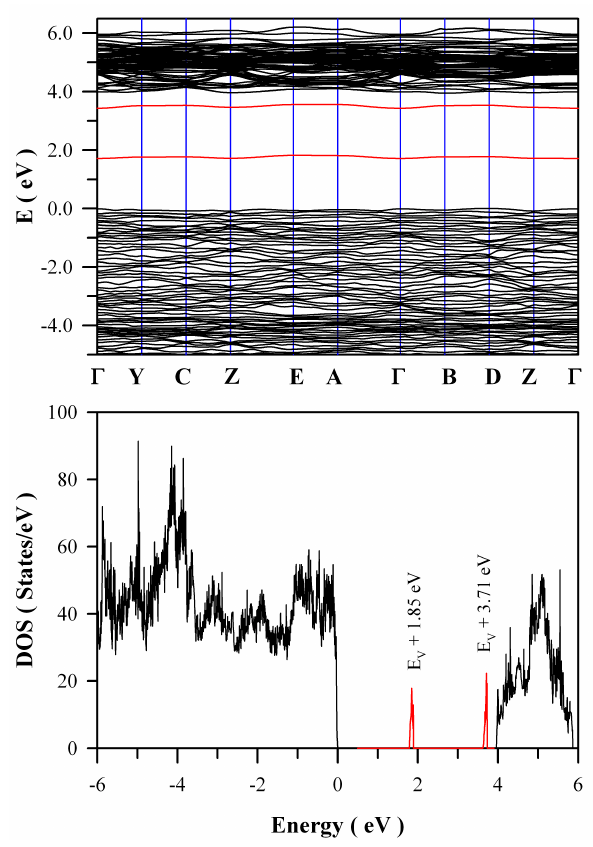
Figure 12. Density functional theory (DFT) calculated electronic structures for oxygen deficient ZnWO 4 (ZnWO 4 − δ where δ = 0.0625): ( a ) band structure; and ( b ) density of states.